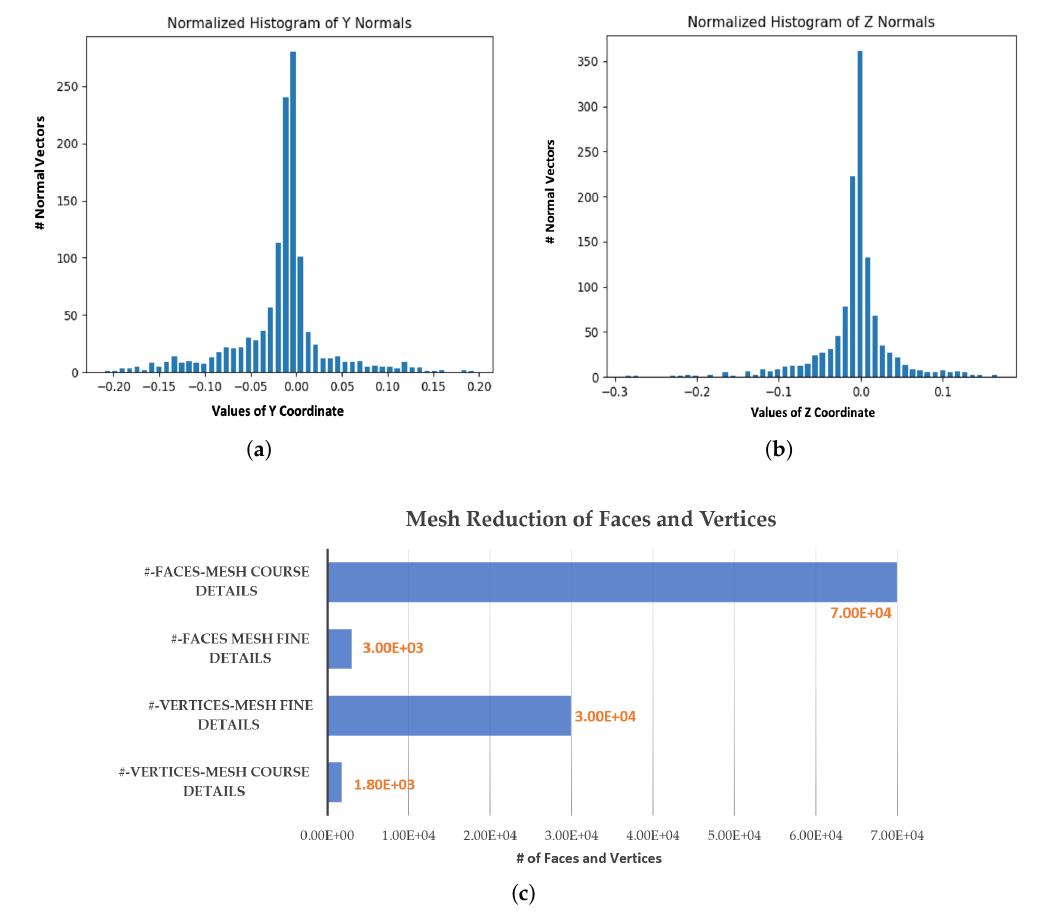
Figure 6. Histograms of the normal distribution for planes extracted from the FTIG Map. Both ( a ) and ( b ) illustrate the probability density of the normal vectors of planar extracted meshes in the transverse (Y normal) and vertical directions (Z normal) used to complete mesh simplification based on the normal vectors. Error distributions in the orthogonal directions to the average normal. The distributions have a standard deviation of 0.05 m. ( c ) Visual representation of mesh vertices and faces.